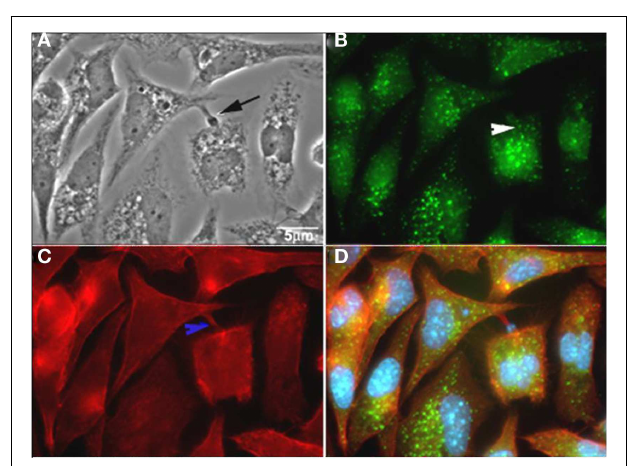
FIGURE 5 | T. cruzi co-localizes with rabankyrin 5 and actin . (A) Phase contrast; (B) rabankyrin 5-Alexa 488; (C) phalloidin-Alexa 546; (D) merge (rabankyrin 5, phalloidin, and DAPI). Arrow indicate trypomastigotes, white arrowhead indicates rabankirin labeling around parasites and blue arrowhead indicates host cell actin around parasites. After Ref.